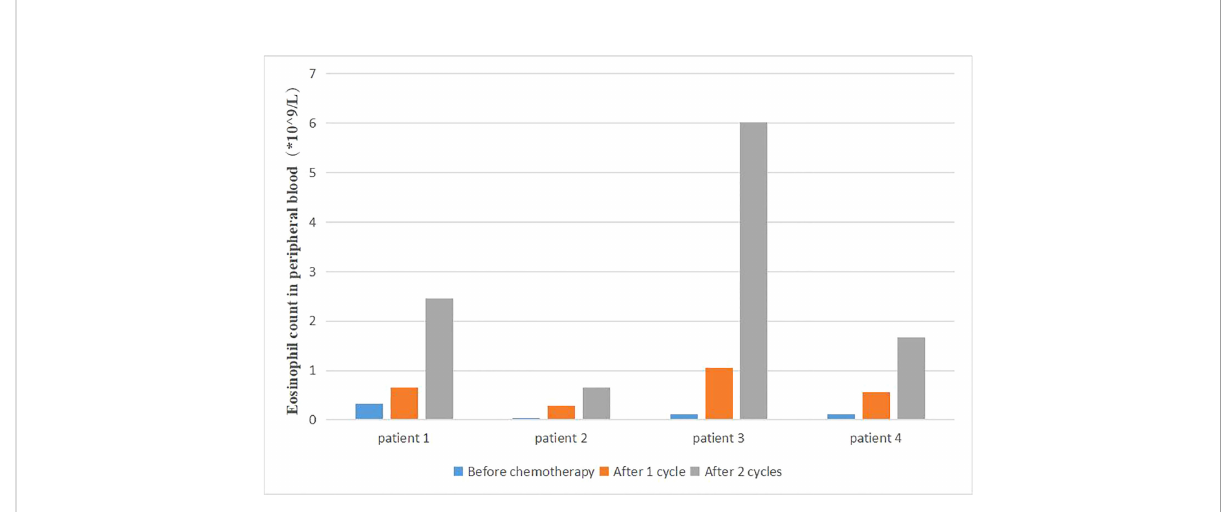
FIGURE 6 Changes of eosinophil count in peripheral blood during treatment.